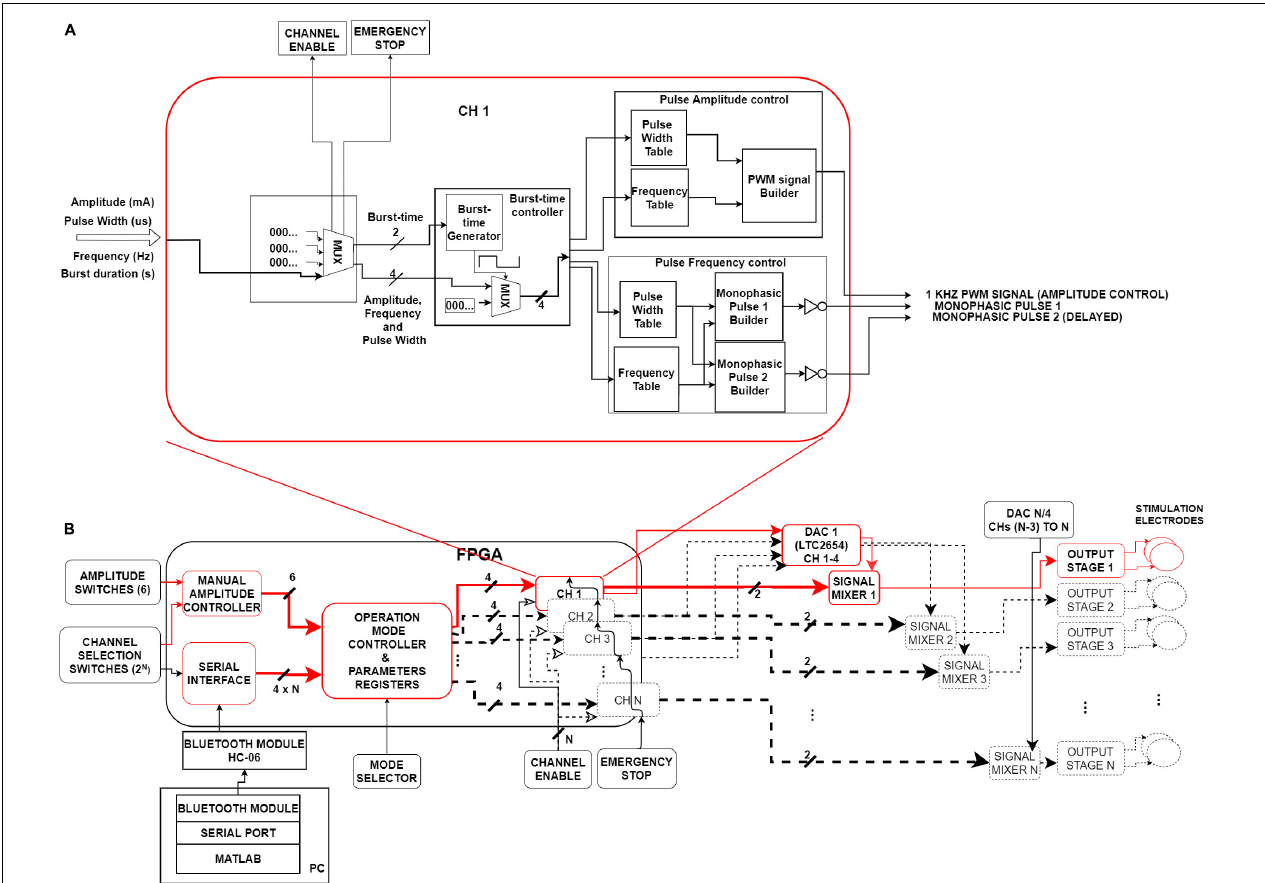
FIGURE 1 | System’s architecture. (A) Internal diagram of a single channel (CH1) of the PG-nFES. This block forms two time-shifted monophasic pulses (frequency and pulse width), and one PMW signal (amplitude). (B) Left. Digital interfaces and logic blocks for management and storing of stimulation options and parameters, and the main PG-nFES blocks (CH 1 to CH N). Right. Analog blocks transform the three FPGA outputs to a pair of monophasic pulses with voltage controlled-amplitude, which are combined in the output stage into a single biphasic, current-controlled stimulation pulses. Red blocks and arrows illustrate the implementation of a single FES channel. Blocks with black dotted lines sketch the scaling capability of the architecture from one to N channels.